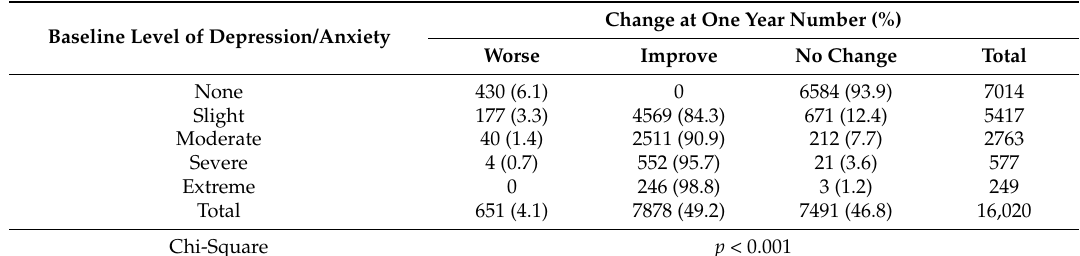
Table 4. Change in Reported Level of Depression and Anxiety at One Year.